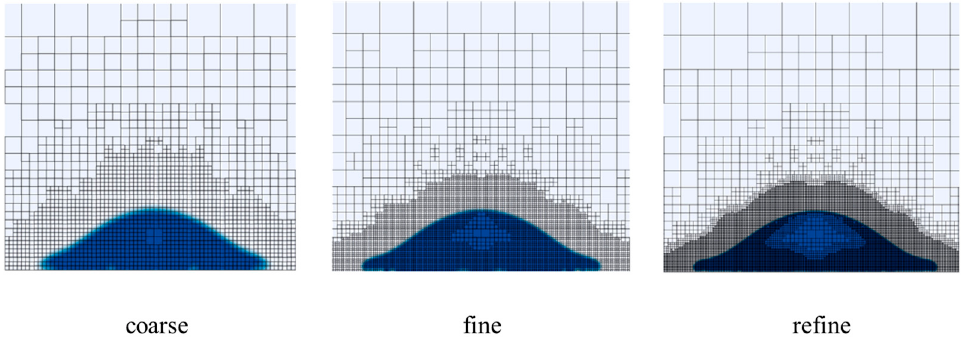
Figure 5. Comparison of grids with different encryption grades.